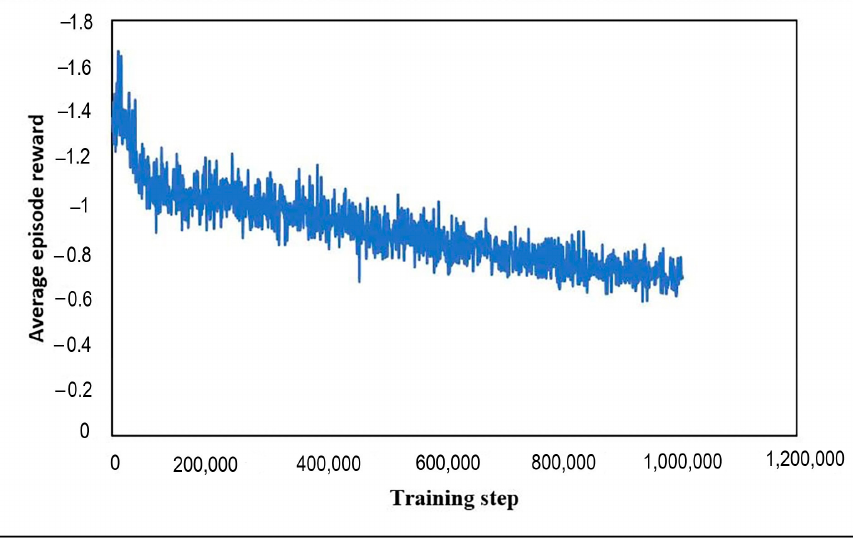
Figure 10. MA2C training curve for Shiraz traffic network.